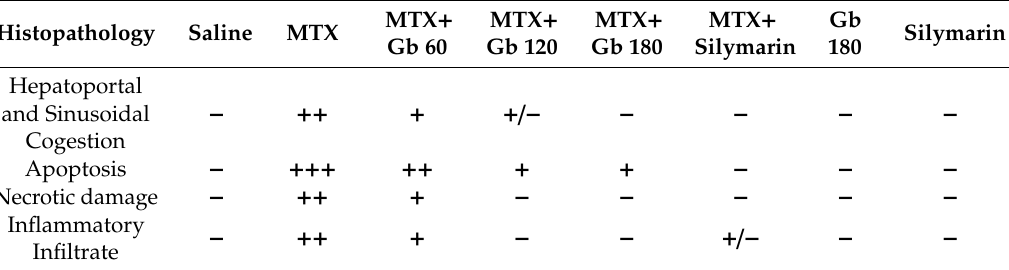
Table 4. Extent of liver damage by MTX.